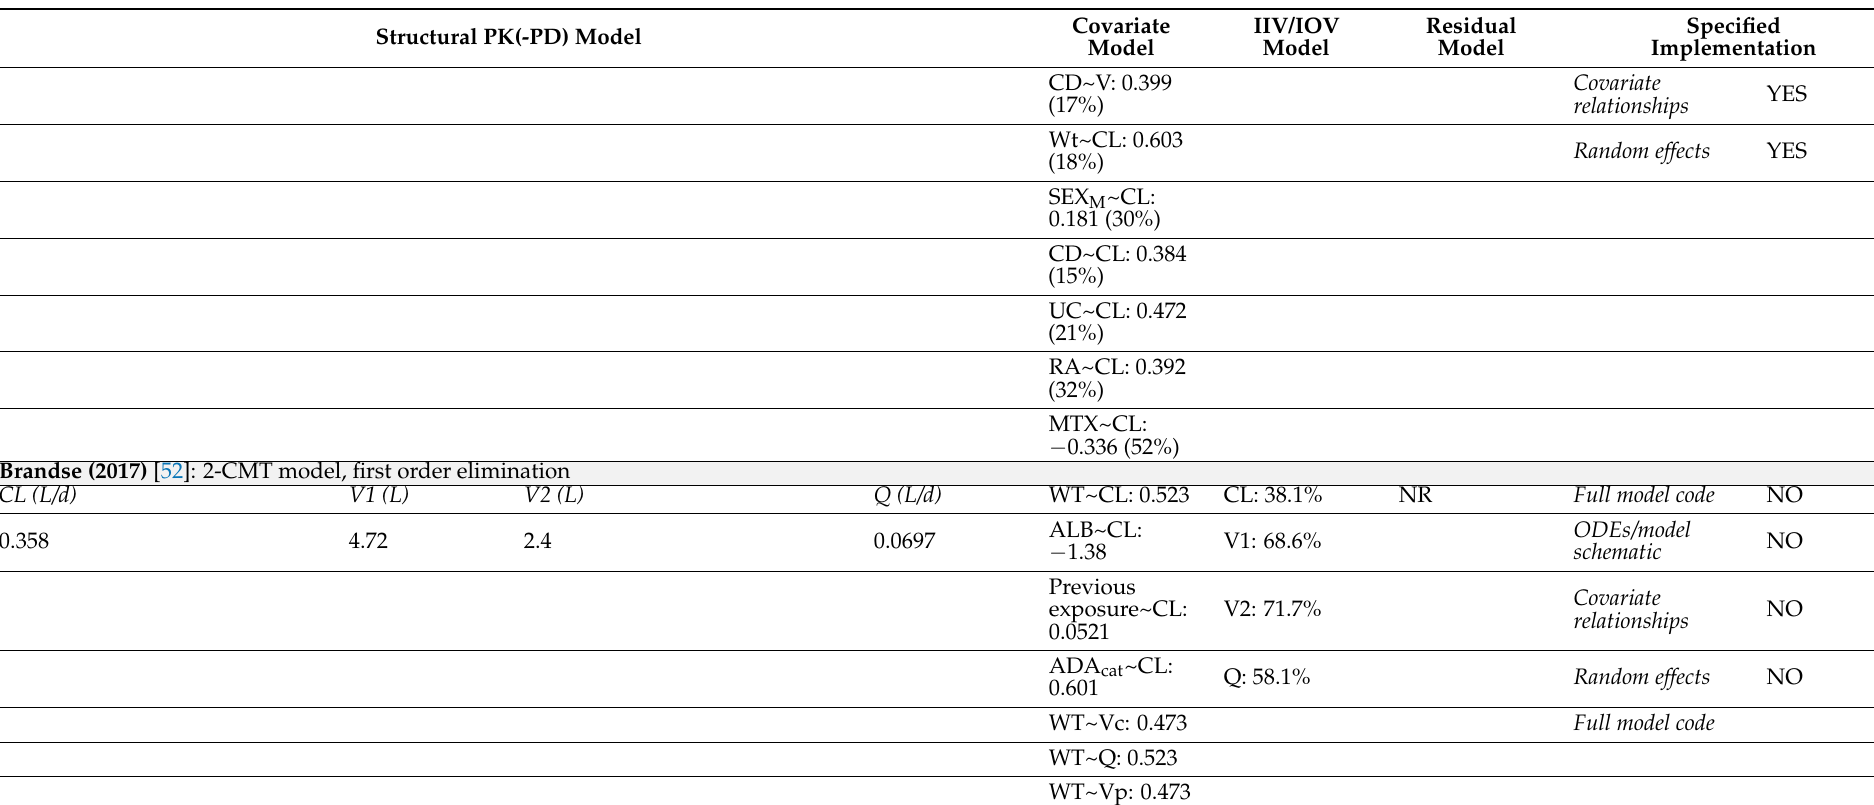
Table 2. Cont. Structural PK(-PD)